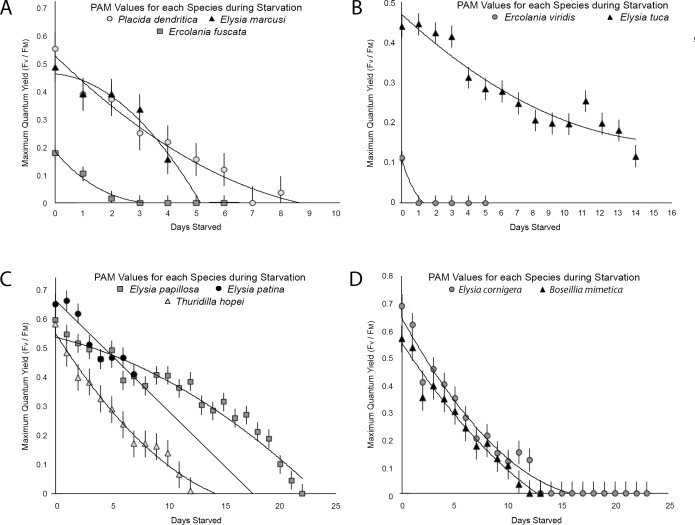
Pulse Amplitude Modulated (PAM) fluorometry values for a range of short-term retention and non-retaining species during starvation.A–The PAM values for Placida dendritica are indicated by light grey circles, Elysia marcusi by black triangles and Ercolania fuscata by dark grey squares. P. dendritica is best modeled by the function y = 4.22x2–103.95x + 610.26 (R2 = 0.97), El. marcusi by y = -15.17x2 + 21.83x + 441 (R2 = 0.92) and El. fuscata by y = -1.59x3 + 28.87x2–169.65x + 320.76 (R2 = 0.98). B–The PAM values for Ercolania viridis are indicated by grey circles and Elysia tuca by black triangles. Er. viridis is best modeled by the function y = -5.14x3 + 63.87x2–248.13x + 296 (R2 = 0.95) and El. tuca by y = 1.14x2–40.43x + 507.49 (R2 = 0.91). C–The PAM values for Elysia papillosa are indicated by dark grey squares, Elysia patina by black circles and Thuridilla hopei by light grey triangles. El. papillosa is best modeled by the function y = -0.55x2–7.54x + 514.6 (R2 = 0.94), El. patina by y = -35.59x + 660.95 (R2 = 0.89) and T. hopei by y = 1.48x2–60.38x + 577.04 (R2 = 0.98). D–The PAM values for Elysia cornigera are indicated by grey circles and Bosellia mimetica by black triangles. El. cornigera is best modeled by the function y = 1.91x2–74.94x + 718.98 (R2 = 0.97) and B. mimetica by y = 1.26x2–62.16x + 615.03 (R2 = 0.97)The error bars show the standard error.